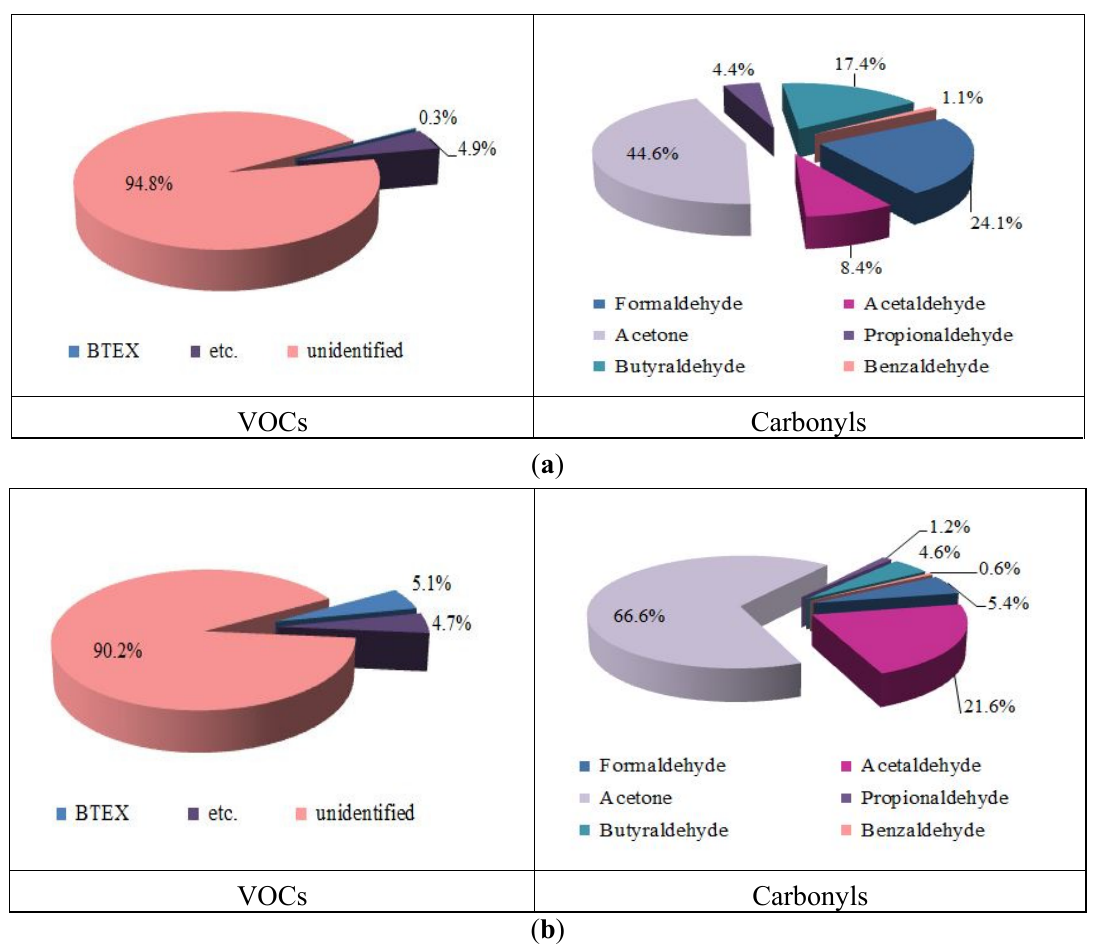
Figure 4. Composition ratio for VOCs and carbonyls from three types of